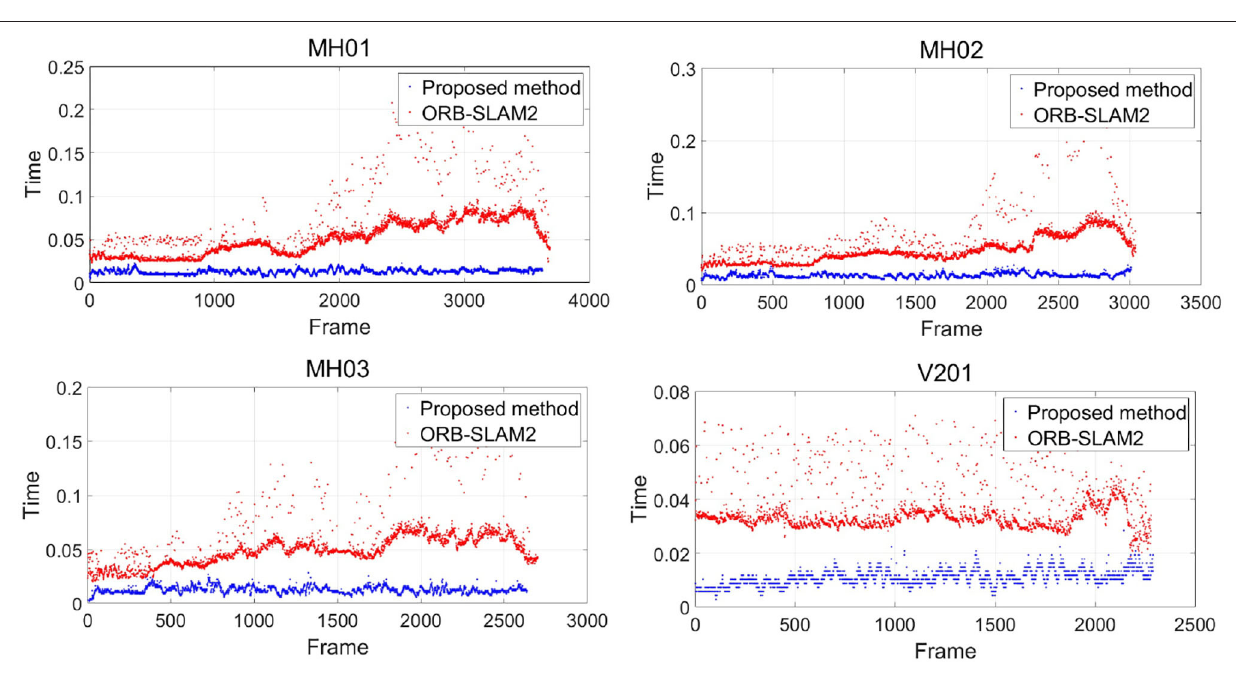
FIGURE 8 | Image processing time distribution per frame.